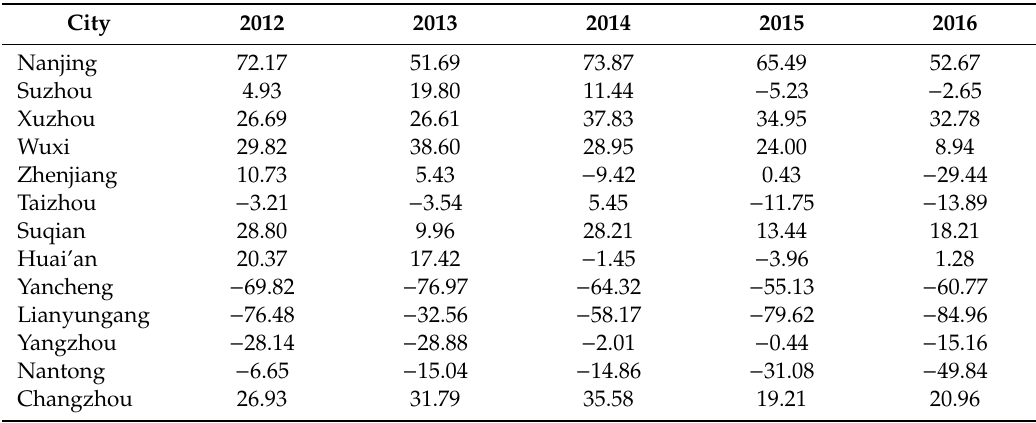
Table 3. Urban ecological civilization score based on STFA.